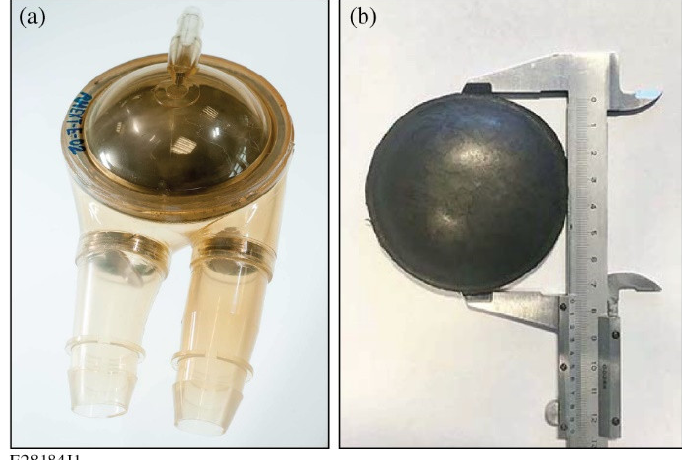
Figure 1. ( a ) Prototype of extracorporeal heart assist device (reprinted with permission [27], copyright 2018, Elsevier); ( b ) graphene nanocomposite pneumatic membrane (calipers provided for